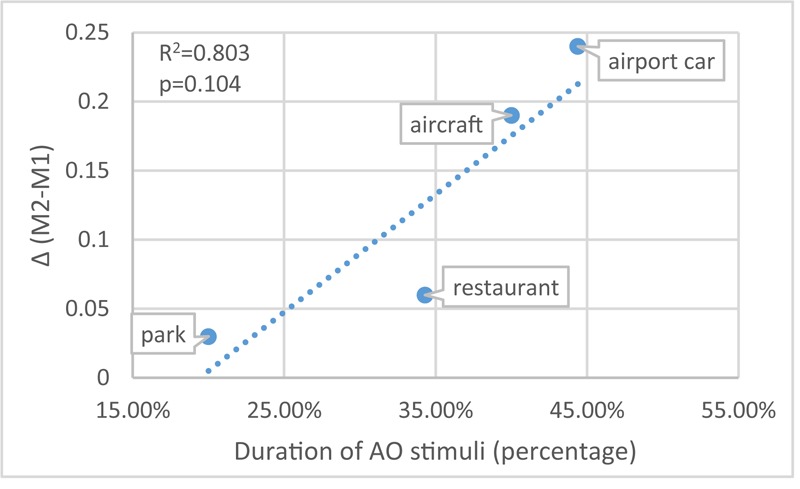
The correlation between AO duration (%) and Δ (M2-M1) (disparity of M1 and M2).